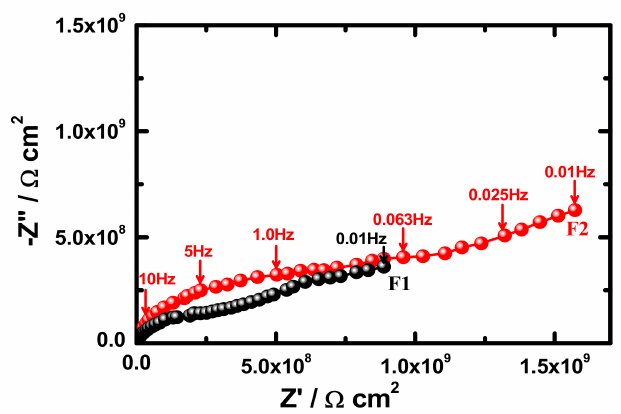
Figure 7. Nyquist plots for coatings F1 and F2 after 7 days’ immersion in the 3.5% NaCl solutions.